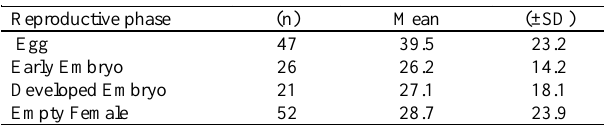
Table 3 . Total mercury concentrations (mean ± S.D. and range in ng.g -1 wet weight) in the parasite Riggia paranensis at four different reproductive stages, from the middle Itabapoana River,